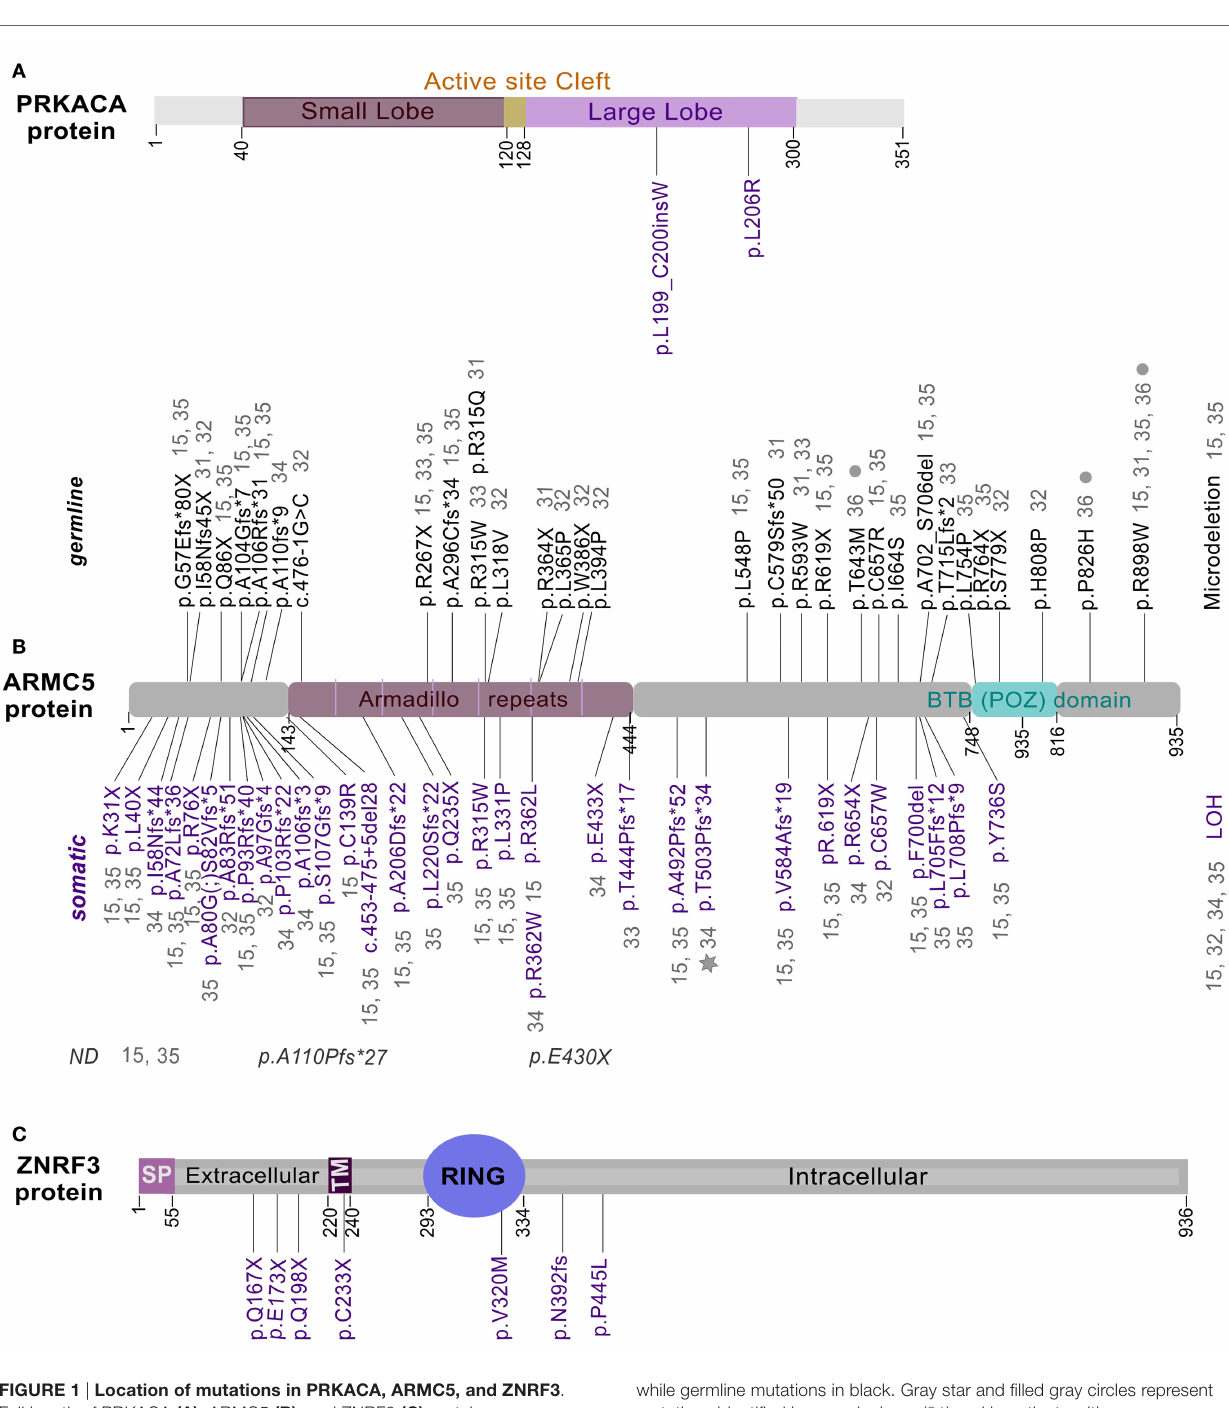
while germline mutations in black. Gray star and filled gray circles represent mutations identified in a meningioma (31) and in patients with hyperaldosteronism (32), respectively. ND, germline or somatic status not